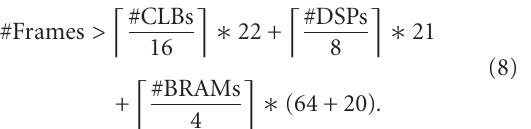
For each design, the place and route report was used to extract the values for the utilized area, this means the required number of CLBs, block RAM (BRAM), and DSPs for the MicroBlaze processor. For task 2, the amount of resources for the accelerator was also taken into